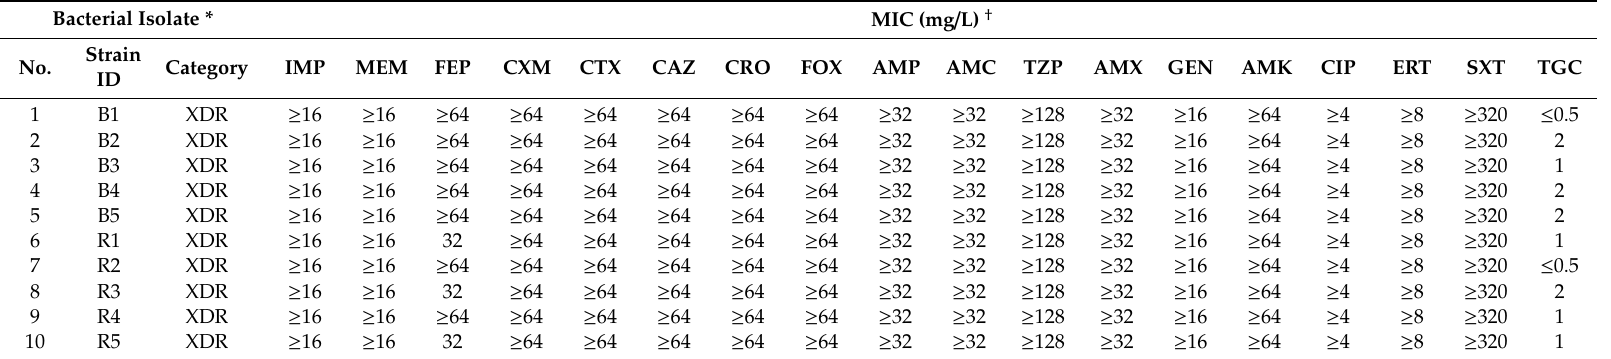
Table 1. Antibiotic susceptibility of the Klebsiella pneumoniae